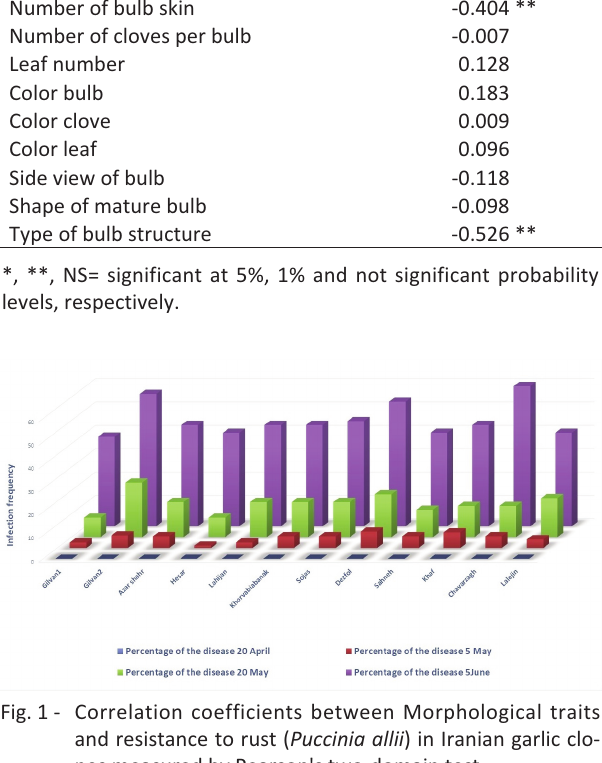
Fig. 1 ­ Correlation coefficients between Morphological traits and resistance to rust ( Puccinia allii ) in Iranian garlic clo­ nes measured by Pearson's two­domain